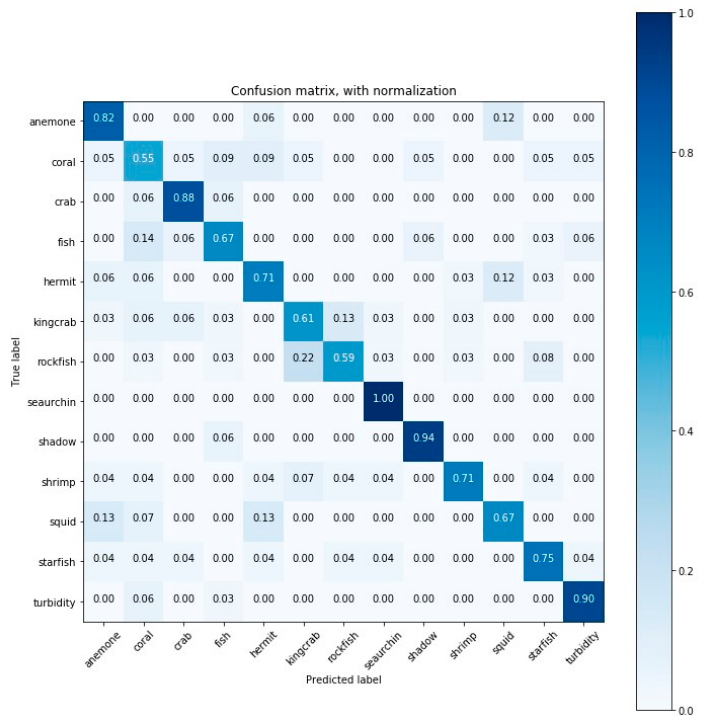
Figure A10. Confusion matrix for the classification results (accuracy) obtained by CNN-3.